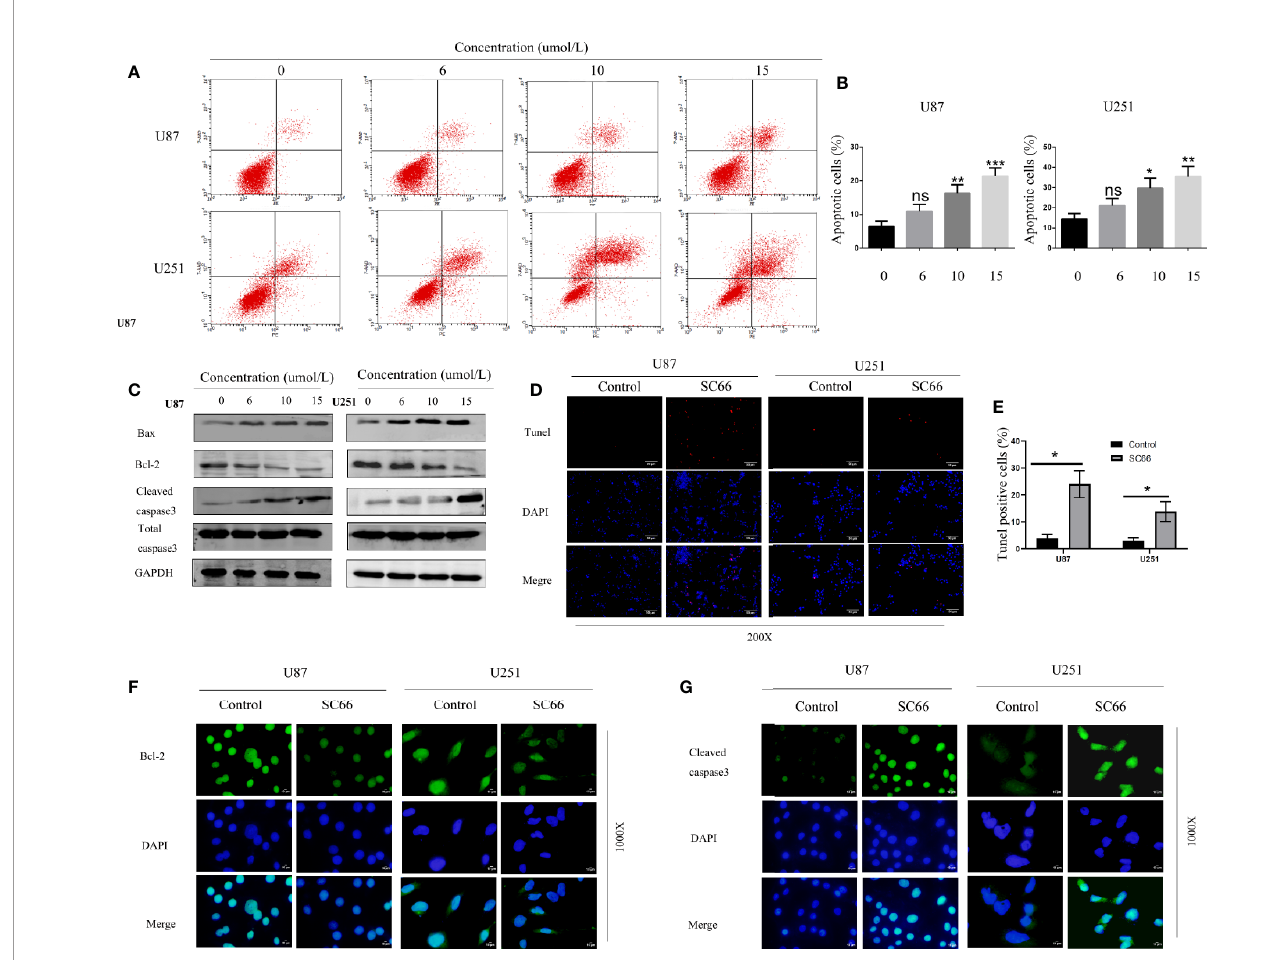
FIGURE 4 | SC66 induced apoptosis of GBM cells in vitro . (A, B) Cells apoptosis were remarkably enhanced after SC66 treatment for 24 h measured by fl ow cytometry and results were statistically analyzed. (C) Cell apoptosis-related protein expression quanti fi ed with western blot. (D, E) U251 and U87 cells death were detected by TUNEL staining. (F, G) Representative fl uorescent images of Bcl-2 and Cleaved- caspase3 in U87 and U251 cells. For at least three independent experiments. n.s., no signi fi cance; *P < 0.05, **P < 0.01, ***P <